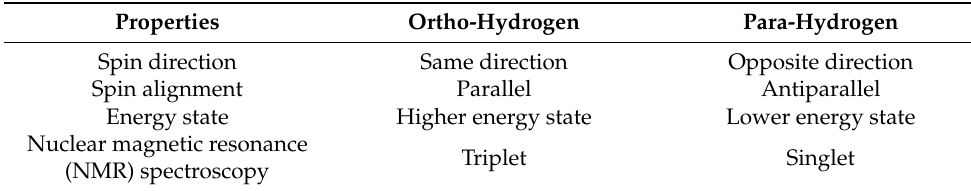
Table 4. Characteristics comparison of ortho- and para-hydrogen